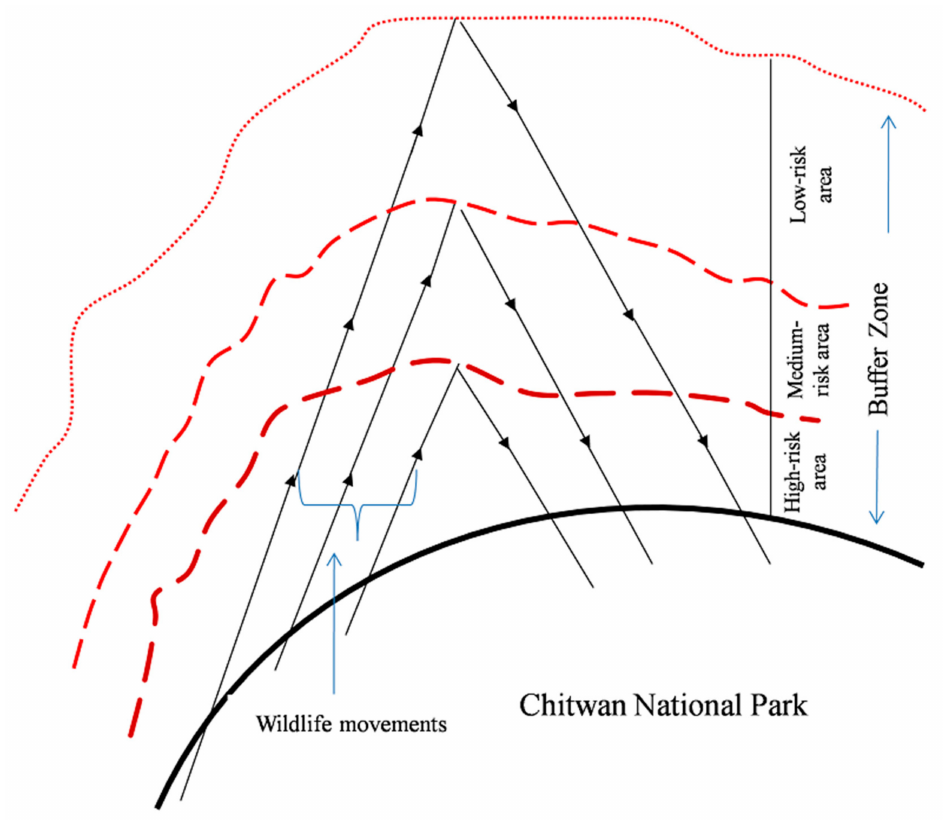
Figure 6. Sketch map of wildlife movement in human-dominated landscapes of Chitwan National Park (the arrows show wildlife movement patterns to and from the